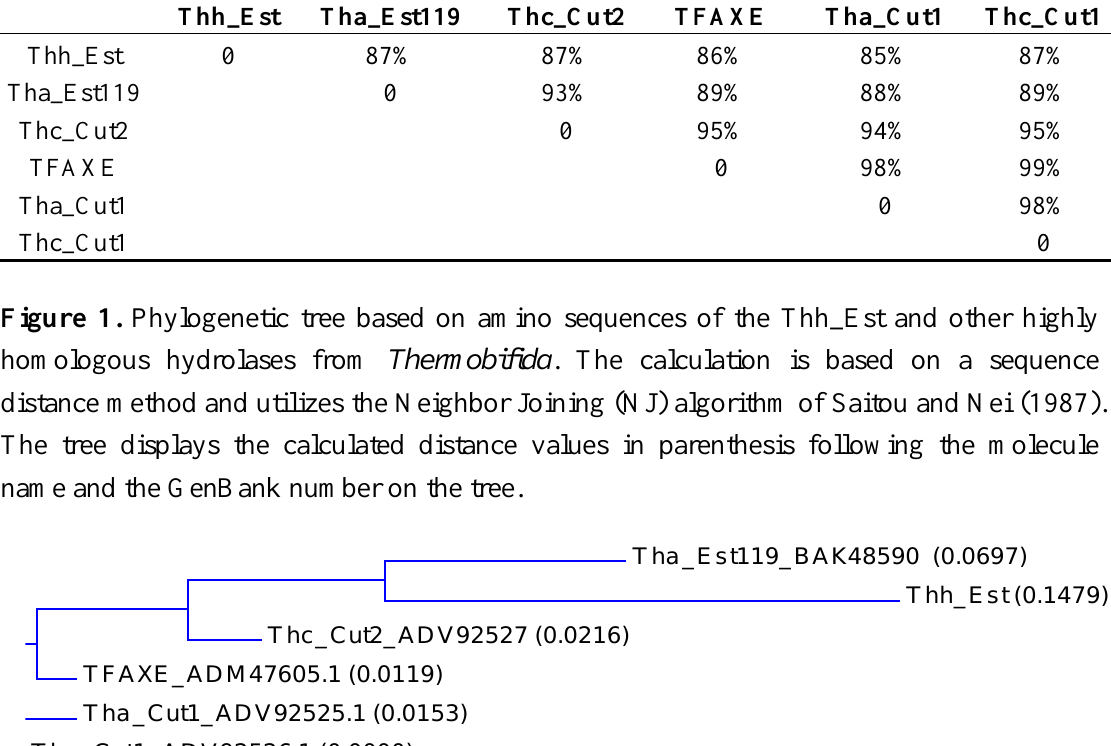
Table 1. Comparison of hydrolases from Thermobifida based on % homology of primary sequences.